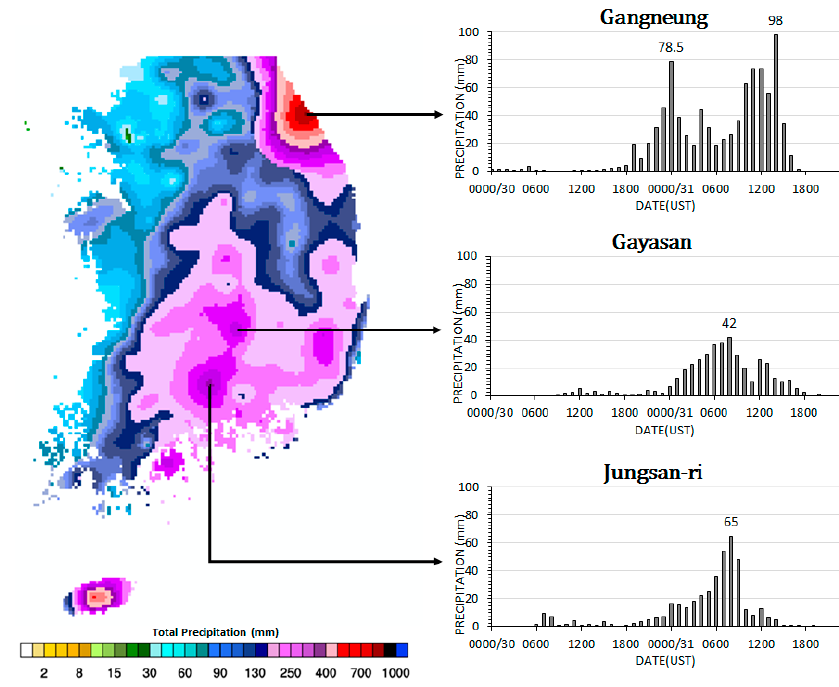
Figure 1. Observed accumulated precipitation and hourly precipitation at Gangneung, Gayasan and Jungsan-ri stations.